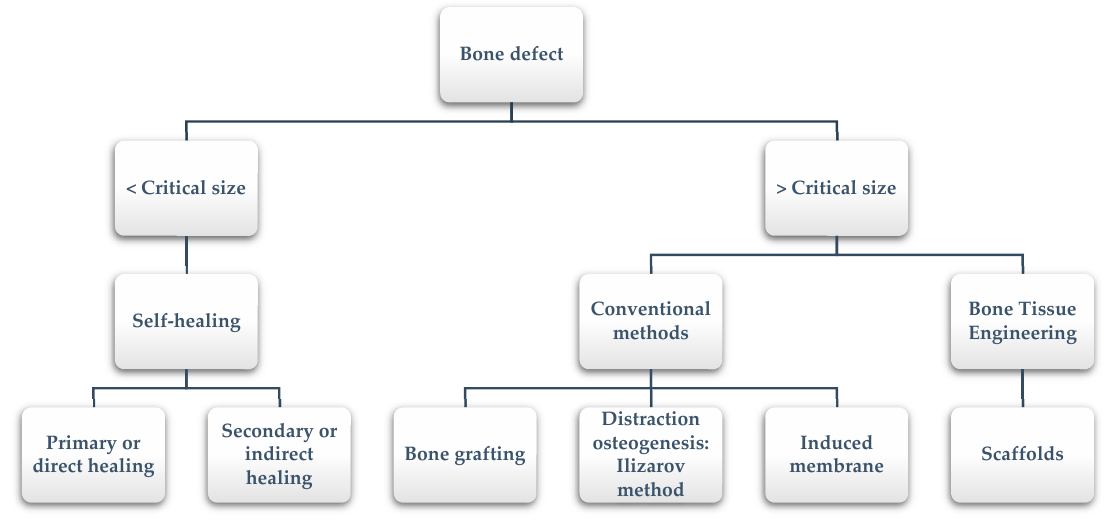
Figure 1. Bone defect healing: from self-healing to bone tissue engineering.